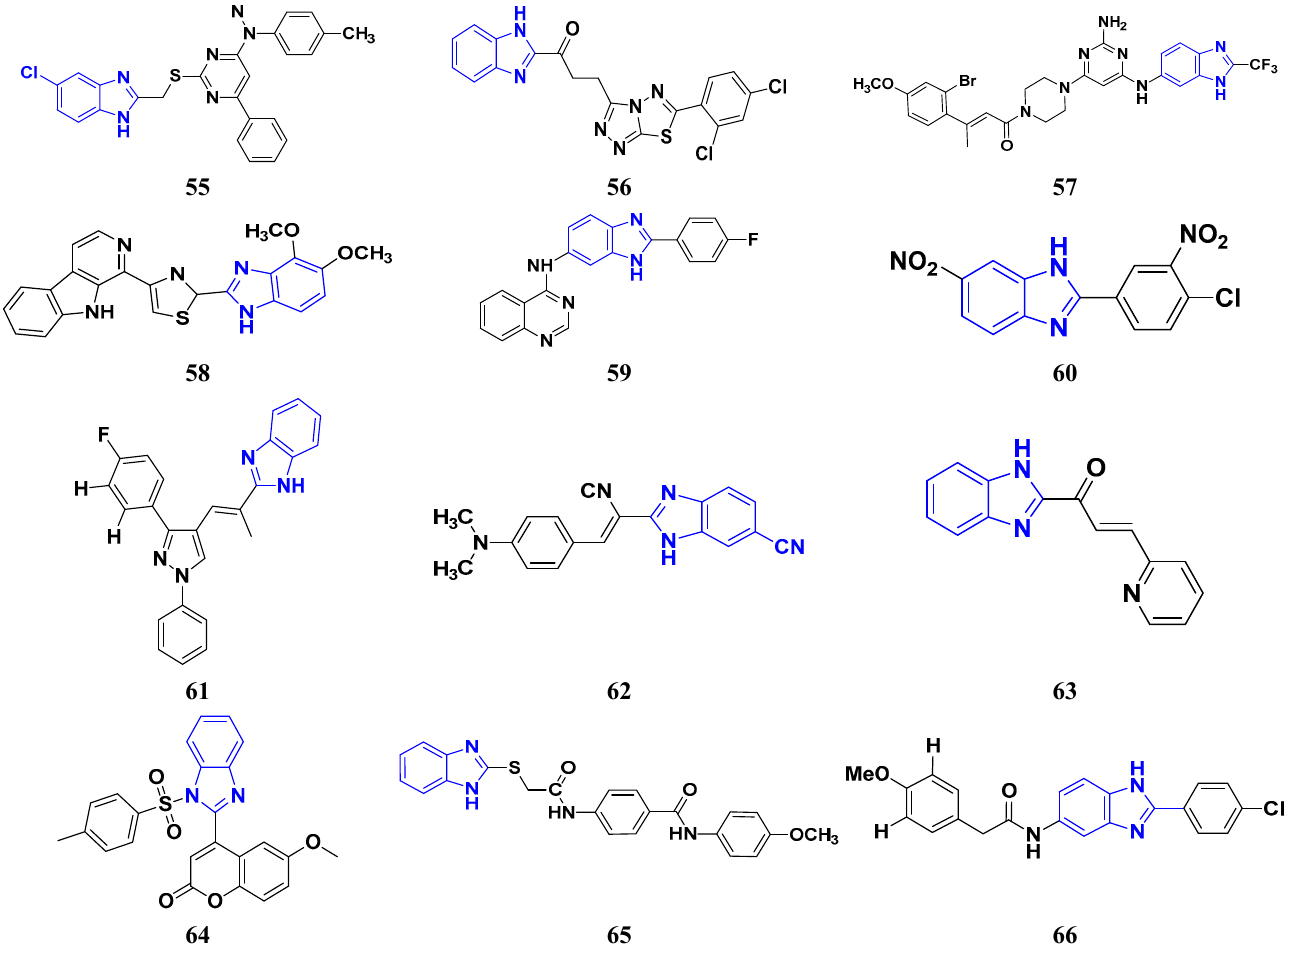
Figure 8. Benzimidazole derivatives ( 55 – 66 ) as anticancer agents.